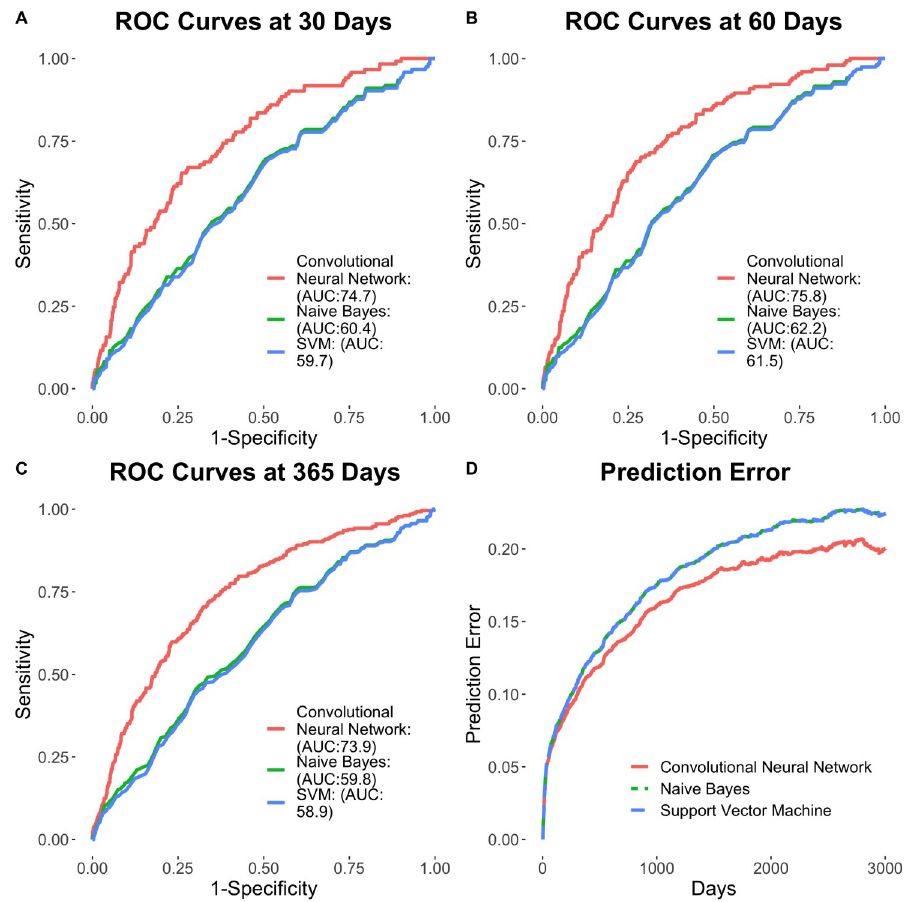
Fig 5. Prognostication of outcomes using the CNN model. (A-C) Time-dependent ROC curves at 30, 60 and 365 days. (D) Time-dependent Brier scores.